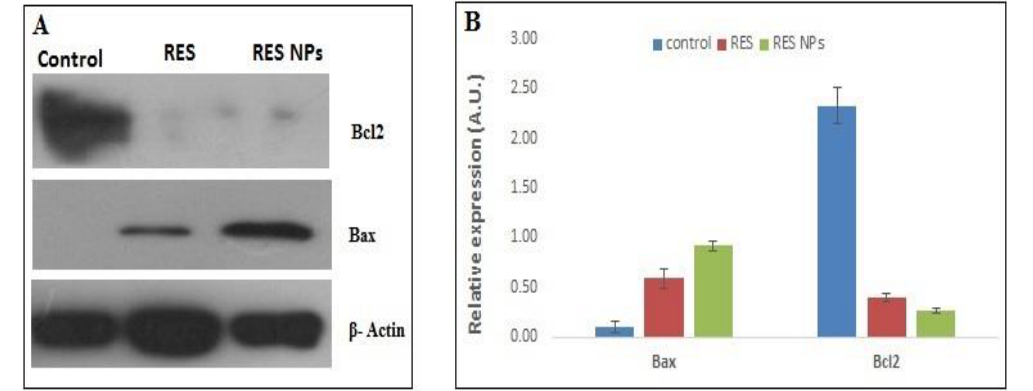
Figure 11. ( A ) Impact of control, free RES, and RES NPs formulations on protein expression of Bax and Bcl-2 levels in H1299 cells through western blotting. ( B ) Densitometric analysis of the bands representing the expression of Bax and Bcl2 was performed using image j software.